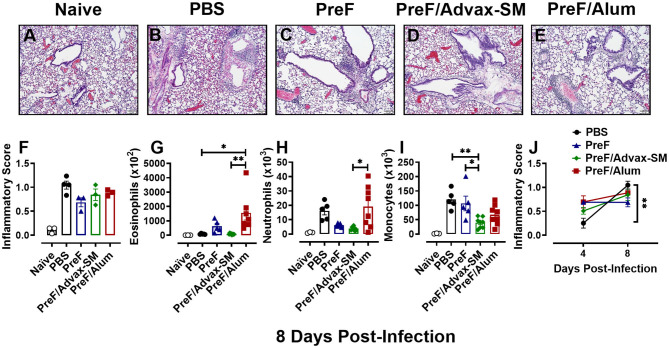
Inflammation worsens over time in unimmunized compared to immunized groups. At 8 dpi, left lungs were formalin fixed and stained with H&E to assess inflammation. Each panel represents an individual mouse from the indicated group (Scale bar 100 μm) (A–E). Two blinded, independent pathologists scored all slides and scores were averaged. Data is represented as mean ± SEM (n = 3–4 mice) (F). BAL was collected at 8 dpi for quantification of eosinophils (G), neutrophils (H), and monocytes (I) via flow cytometry. Data are represented as mean ± SEM (n = 6–8 mice). Inflammatory scores from 4 and 8 dpi were compared for each immunization groups over time (J). Data are represented as mean ± SEM (n = 3–4 mice); *p < 0.05 and **p < 0.01.